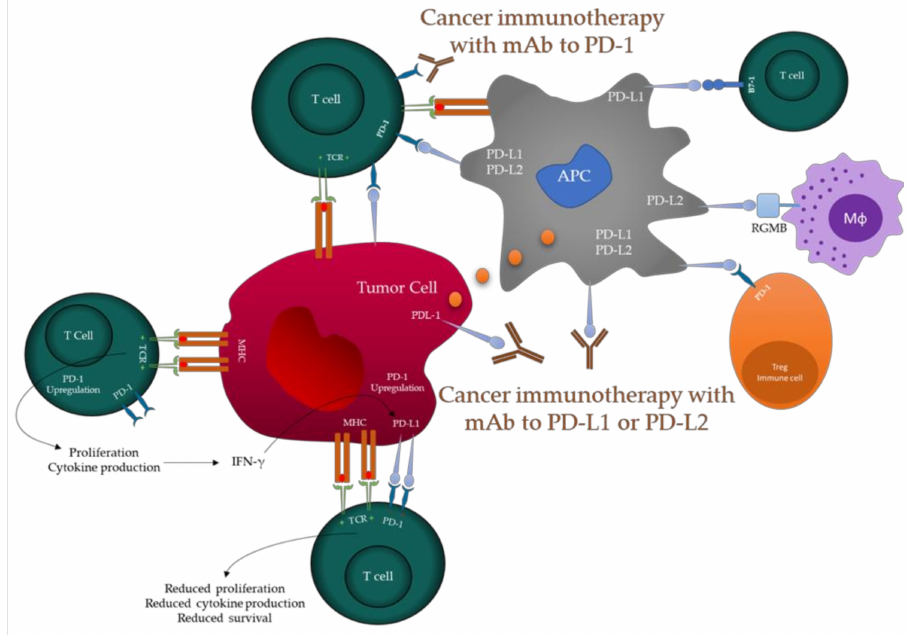
Figure 1. Schematic diagram for anti-programmed death protein 1 (PD-1) and anti-programmed death-ligand 1, 2 (PDL-1, PDL-2)-mediated immunotherapy for HCC. Antigen-presenting cells (APCs) acquire antigen (Ag) produced by cancer cells and deliver it to T cells to activate T-cell receptors (TCRs). Moreover, cancer cells may deliver Ag to activated T cells within the framework of MHC. During T-cell activation, PD-1 receptors are expressed on T cells and suppress immunological responses via the interaction with PD-L1 and PD-L2 on APCs and PD-L1 on cancer cells, consequently blocking the PD-1/PD-L1/PD-L2 pathway using a monoclonal antibody (mAb). Modified from